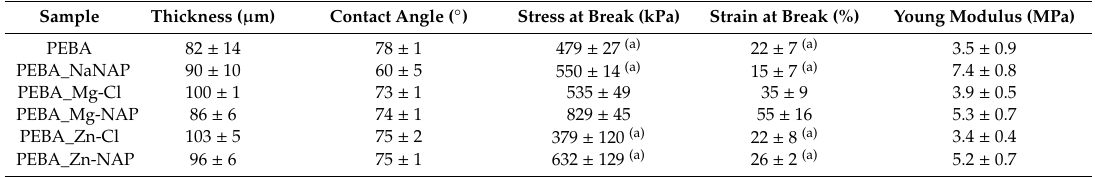
Table 2. Thickness, water static contact angle, stress and strain at break and Young modulus of pristine PEBA membrane and PEBA